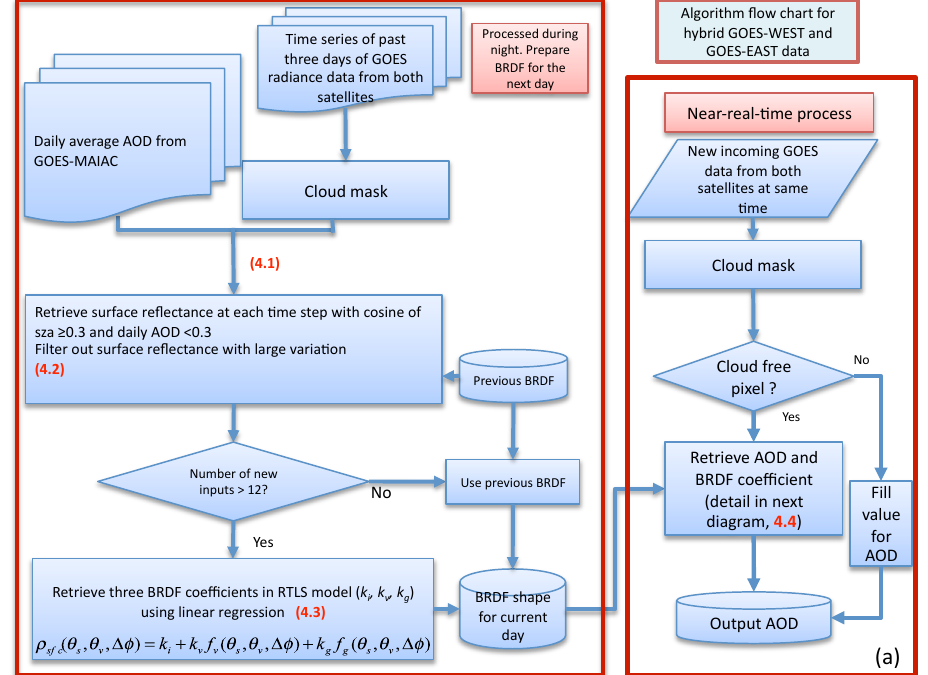
Fig. 5. (a) Flow chart. Section number descriptions in the text are noted to help follow the flow of the hybrid AOD and BRDF retrieval algorithm. (b) Detailed steps for AOD and BRDF coefficient retrieval in (a)